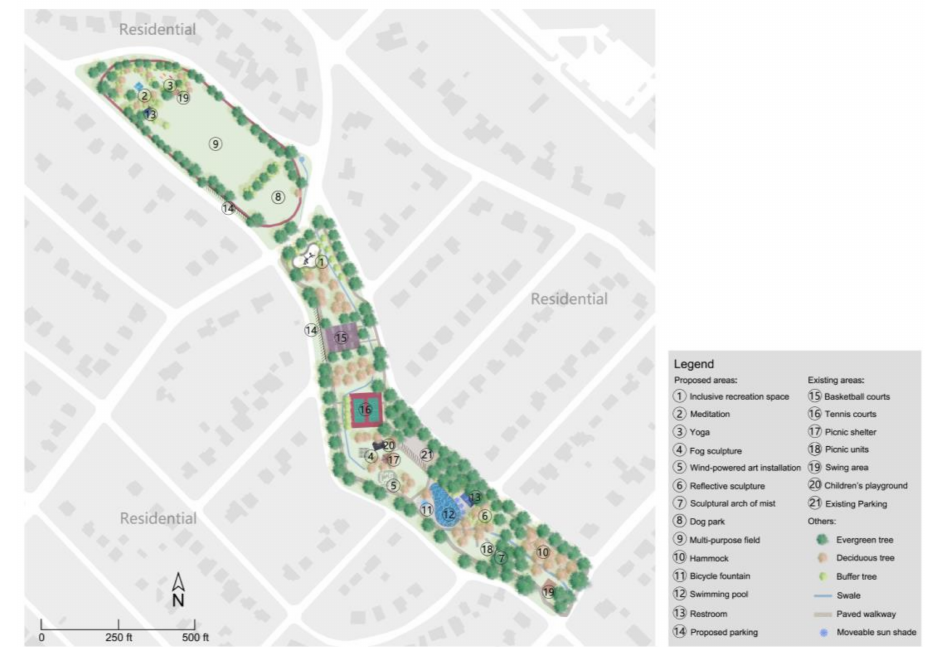
Figure 3. Thomas Park’s proposed master plan.